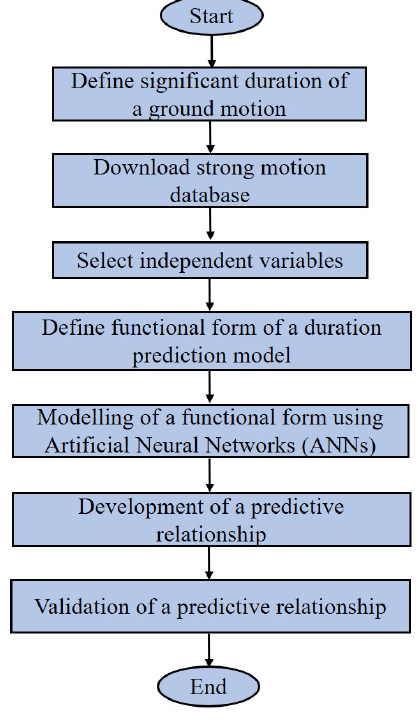
Fig. 1. Overview of research